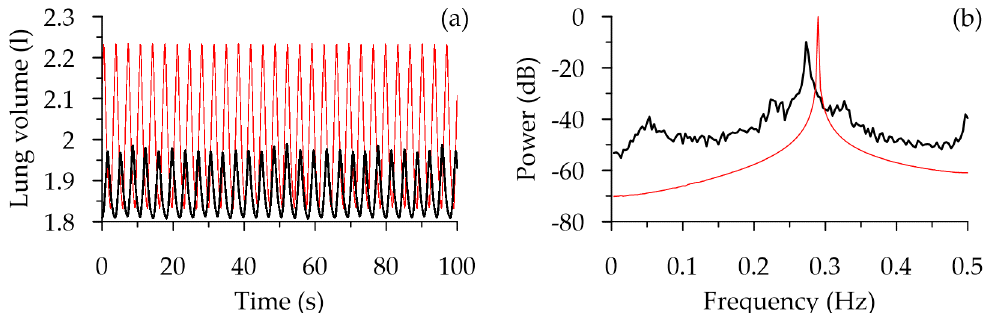
Figure 3. Time series ( a ) and Fourier power spectra ( b ) for the model aortic arterial pressure signal. The black bold lines correspond to a healthy subject, and the red thin lines correspond to the simulation of the blockade of the regulation of respiratory amplitude and frequency.